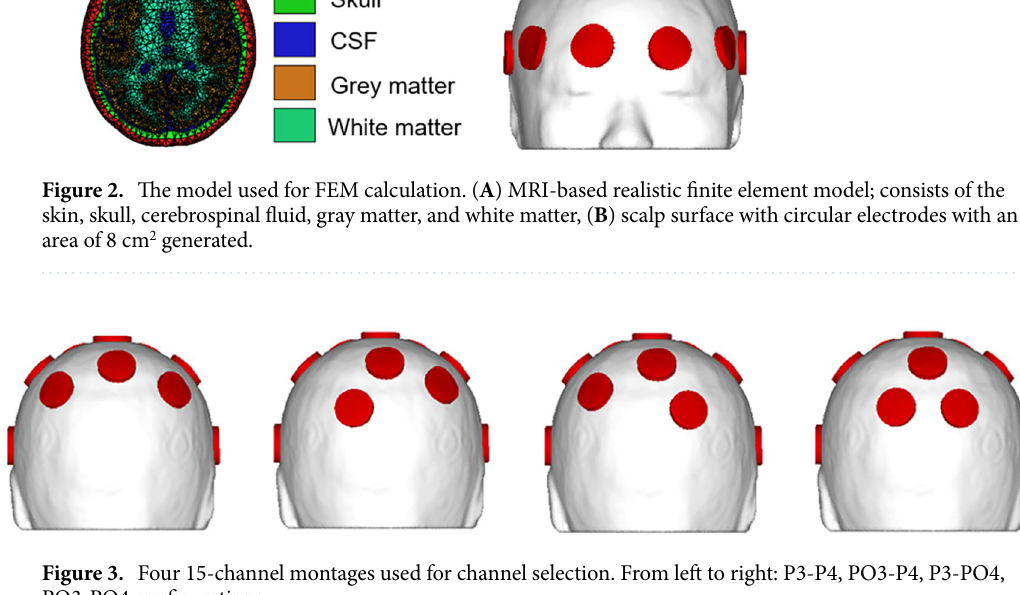
Figure 3. Four 15-channel montages used for channel selection. From left to right: P3-P4, PO3-P4, P3-PO4, PO3-PO4